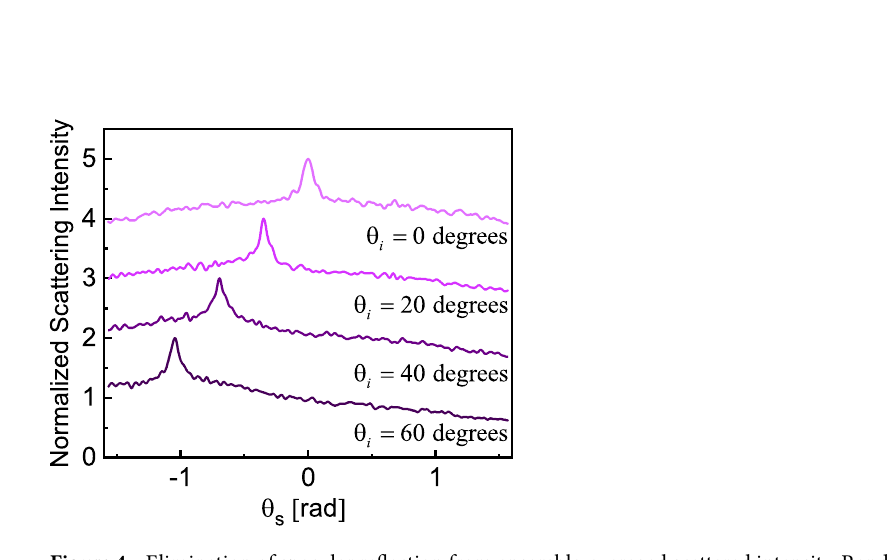
Figure 4. Elimination of specular reflection from ensemble-averaged scattered intensity. Random samples are similar with those used in Fig. 3, where an artificial random surface is added on top of the medium shown in Fig. 1. The angle of incidence is set at θ i = ( 60, 40, 20, 0 ) (deg) (different colors). The darker colors corresponding to higher incidence angles. N r = 2, 000 and the maximum value (CBS peak) of all curves are normalized to two. Each curve is moved one unit up compared to the previous one for better